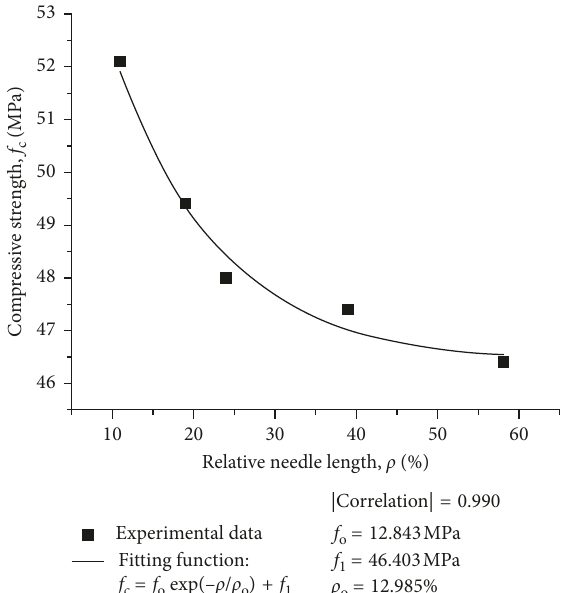
Figure 8: The decreasing sequence of compressive strength of cement mortar in dependence on relative needle length. The ex- perimental data are identical to those presented in Figure